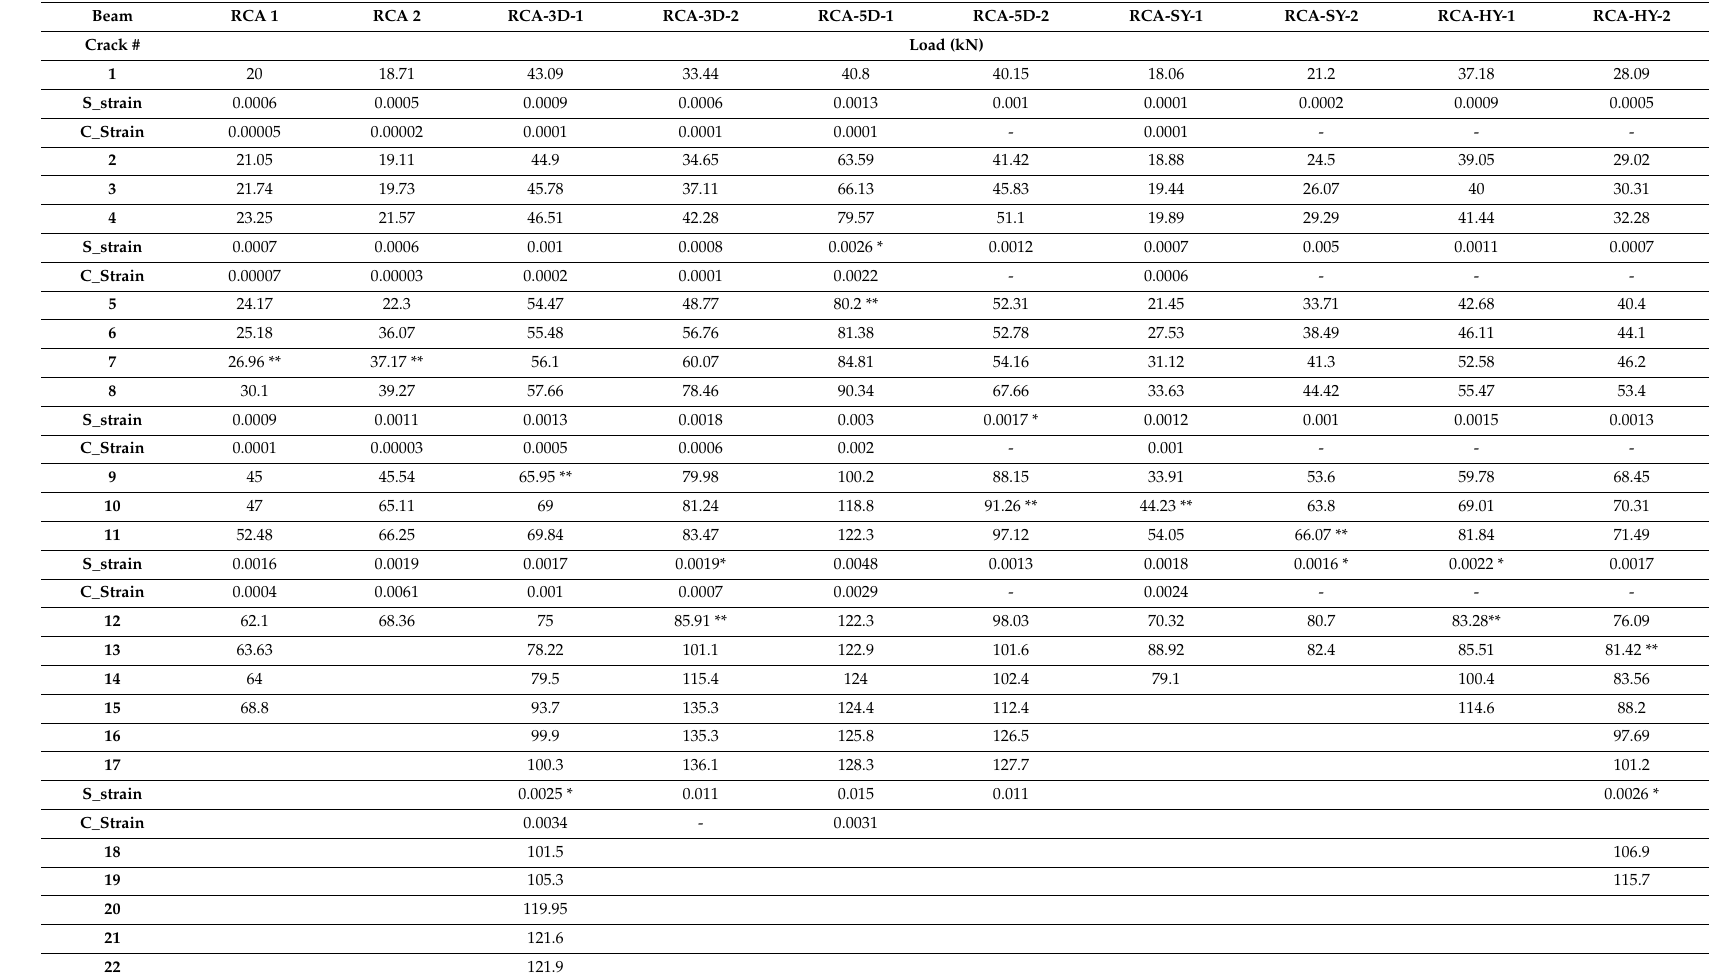
Table 13. Summary of crack, corresponding loads, and